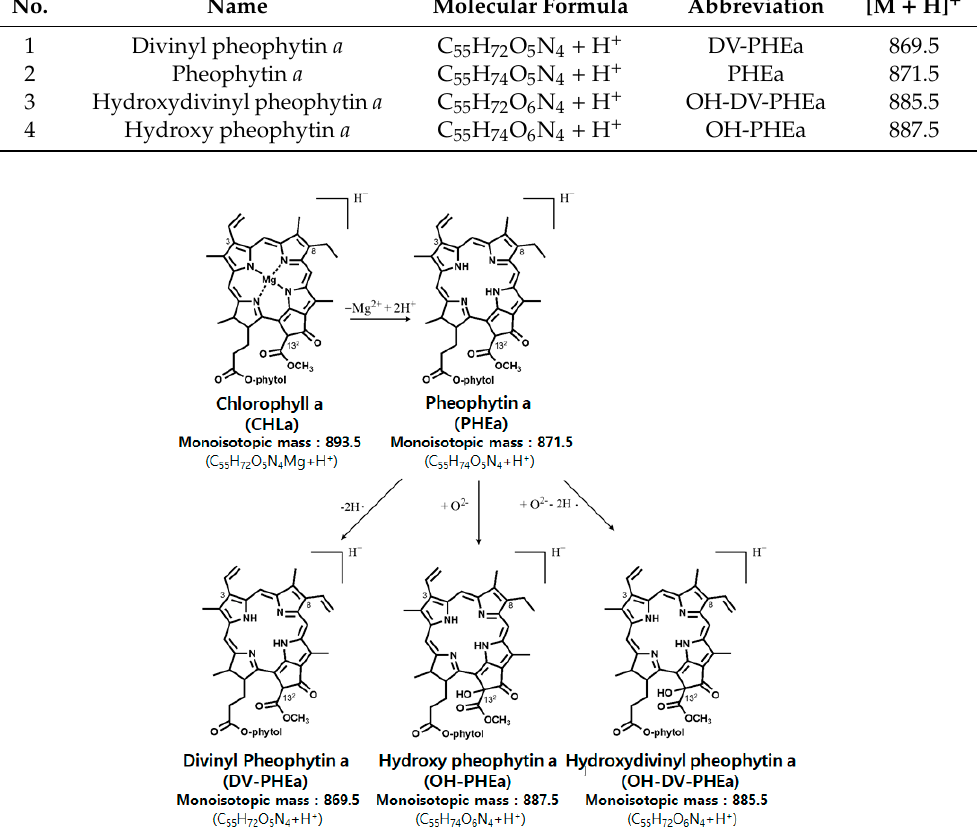
Figure 3. Structures and monoisotopic masses of the chlorophyll a